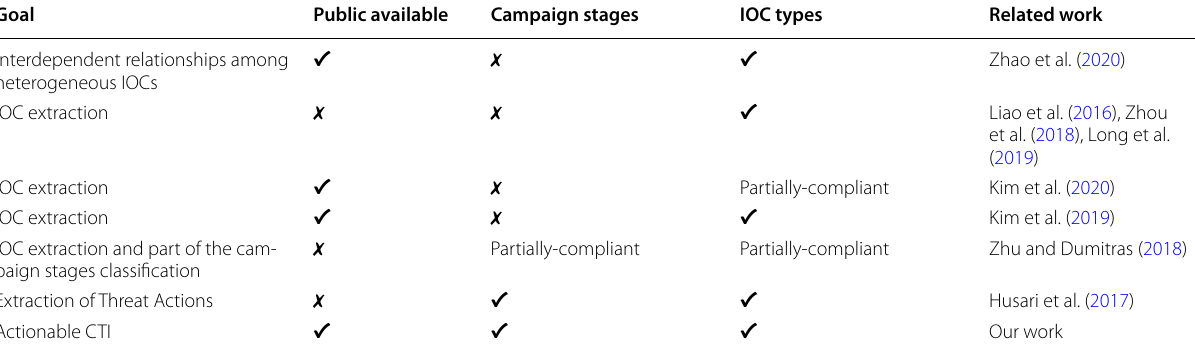
Table 6 Overview of goals and additional specifications of CTI discovery